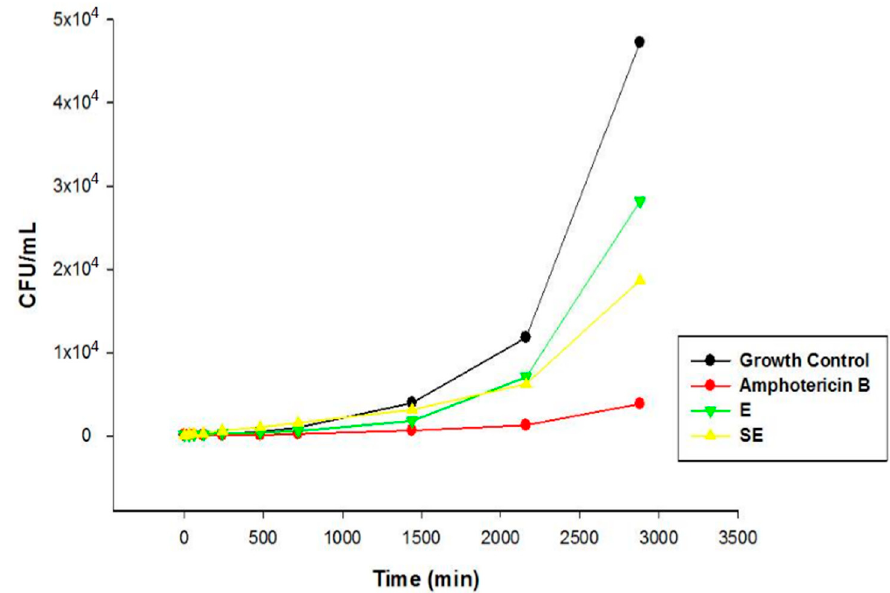
Figure 9. Time kill assay of ATCC 10231 strain. Legend: E = Extract solution (without incorporation); SE = Formulation with extract.